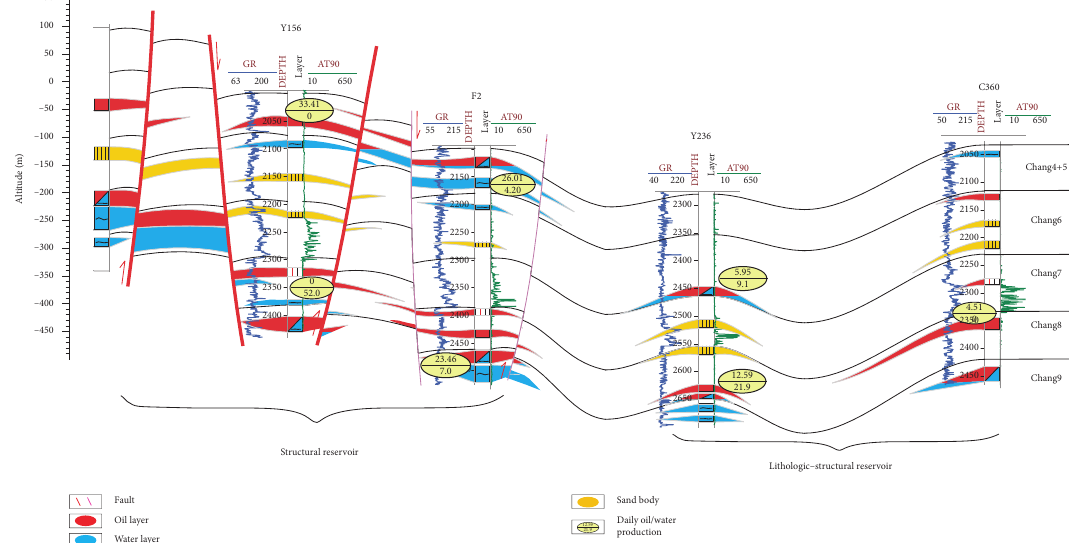
Figure 11: Distribution of main reservoir types in the Yanchi area of the northwest Ordos Basin (the profile position is shown in Figure